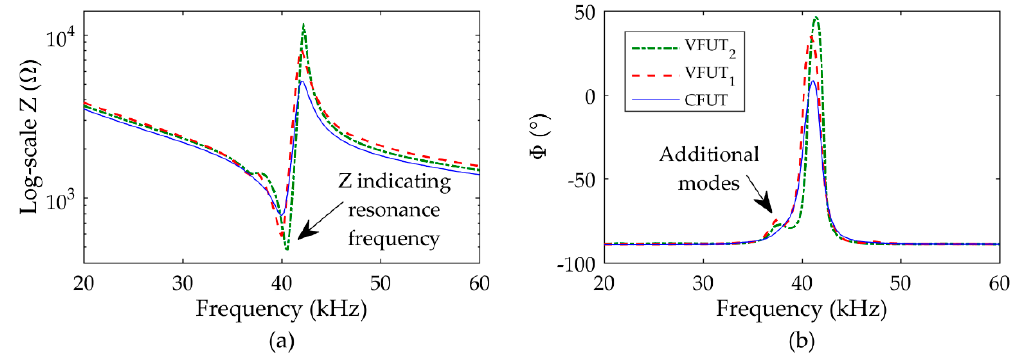
Figure 5. Electrical characteristics as functions of frequency for the transducers at standard room pressure (1 bar) and temperature: ( a ) electrical impedance; ( b ) phase.